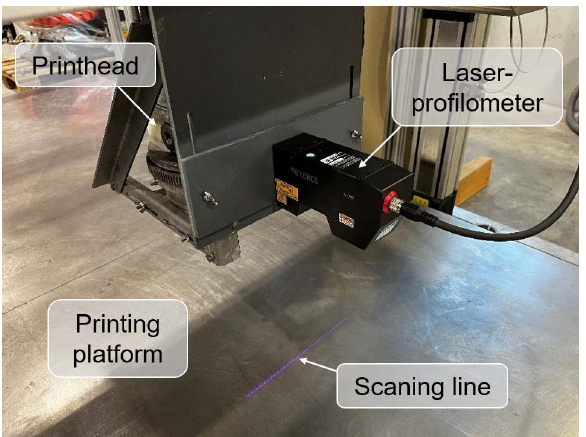
Figure 6. Laser-profilometer Keyence LJ-V7300 mounted on the printhead of the gantry 3D printer and used to evaluate surface roughness.